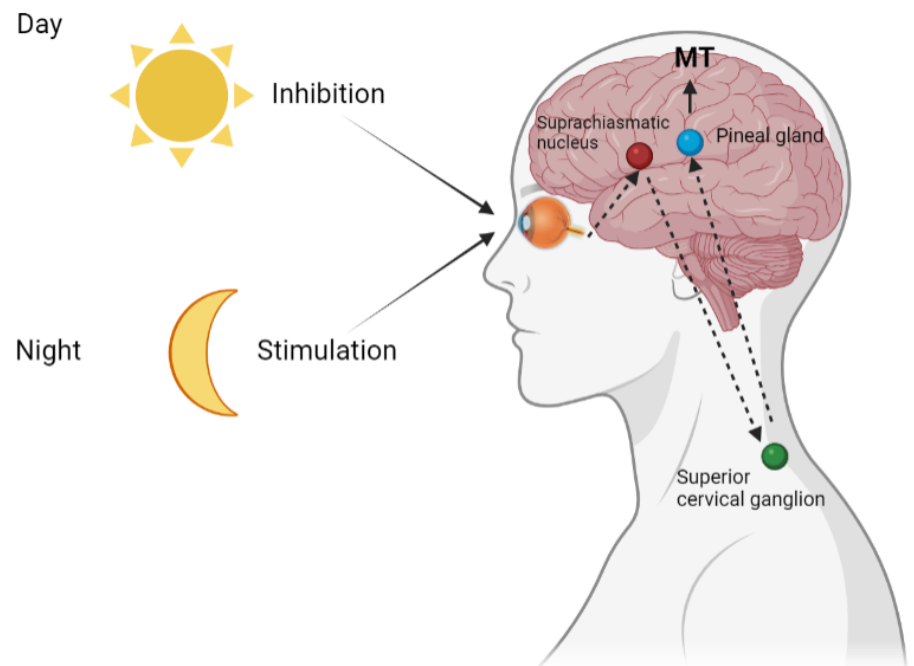
Figure 2. Melatonin is the main regulator of the circadian rhythm in all living organisms. Light information from the rods and cones of the retina through the ganglion cells and directly from the light-sensitive ganglion cells enters the paired suprachiasmatic nucleus (SCN) of the hypothalamus. These signals then travel to the cervical spinal cord, from where they travel back to the brain and reach the pineal gland. During sleep in the dark, when most of the SCN neurons are inactive, the nerve endings release norepinephrine, which activates the synthesis of melatonin in the pinealocytes. Bright light blocks the synthesis, while in constant darkness, the rhythmic production, maintained by the periodic activity of the SCN, is preserved.